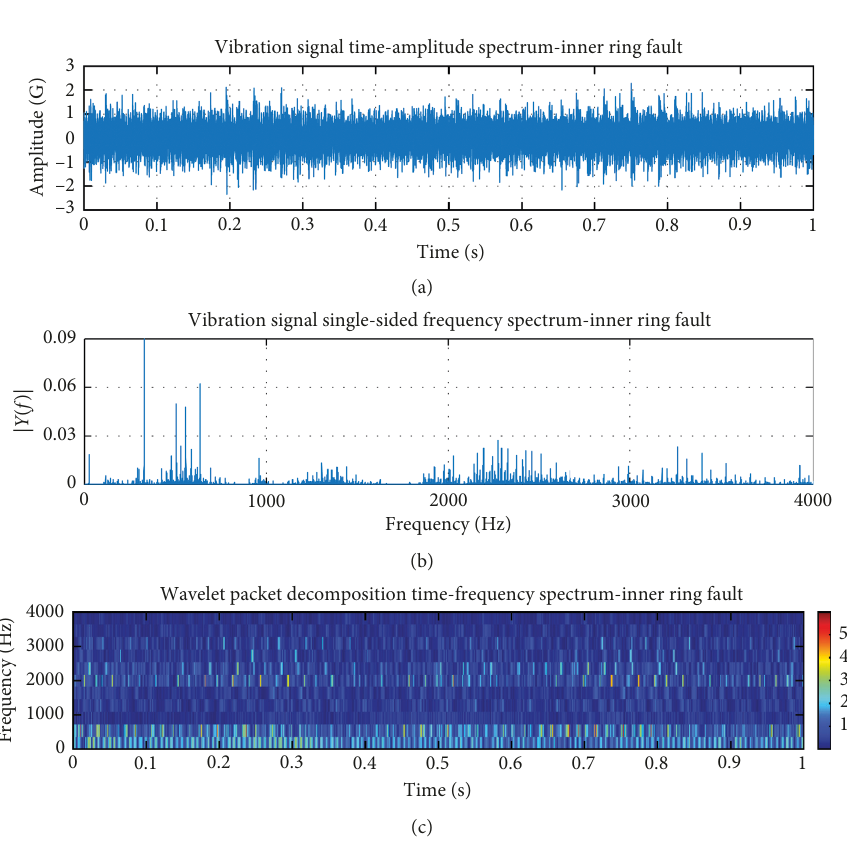
Figure 11: Vibration signal of the inner ring fault: (a) time-domain response; (b) FFT; (c)